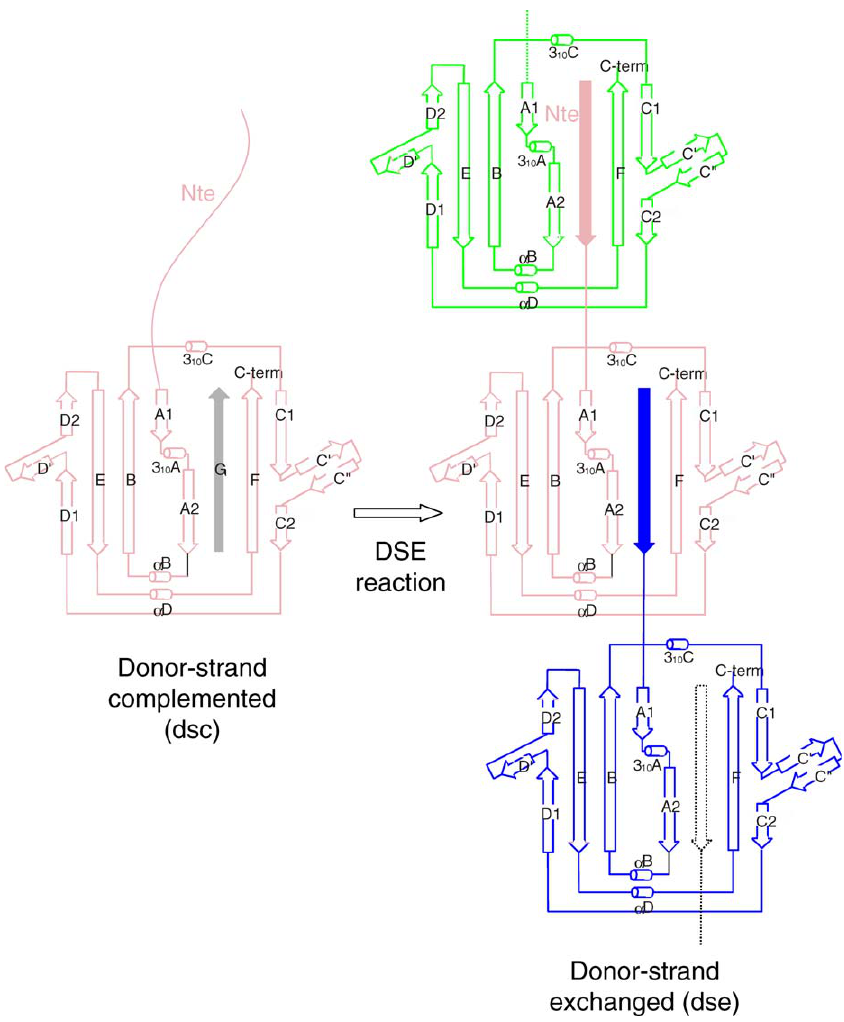
Figure 1. Schematic Diagram Illustrating the Processes of DSC and DSE In this diagram, b -strands and helices are represented as arrows and cylinders, respectively. At left, a topology diagram of a subunit bound to the chaperone is shown in pink. The Nte is shown as a disordered region at the N-terminus of strand A1. In the chaperone, only the G 1 strand is shown in gray: it complements the fold of the subunit by inserting between strands A2 and F, providing in trans the missing G strand. Note that the complementing G 1 strand runs parallel to strand F, thereby reconstituting an atypical Ig-fold for the subunit. The donor–strand-complemented subunit is referred to in the text as ‘‘ dsc ’’ . At right, the same subunit in pink is shown in the pilus. Its Nte is now inserted between strand A2 and F of the subunit in green. Its groove is now filled with the Nte of the subsequent subunit in dark blue. The subunit is referred to in the text as ‘‘ dse ’’ .